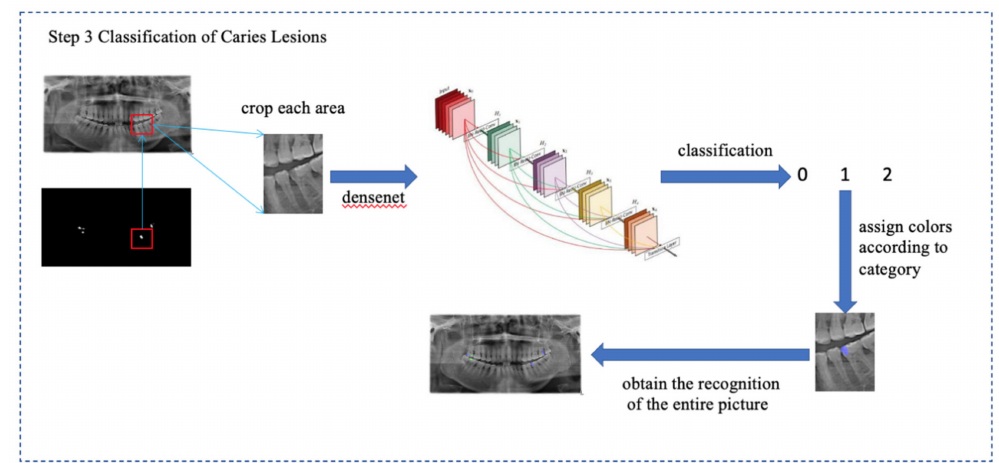
Figure 2. Description of how caries lesions were classified into D1/D2/D3 lesions. First, caries lesions were identified by the model as 3 types, which were represented by the code 0/1/2. Code 0 indicates D1 lesions (which are shown as red circles), Code 1 indicates D2 lesions (which are shown as green circles) and Code 3 indicates D3 lesions (which are shown as purple